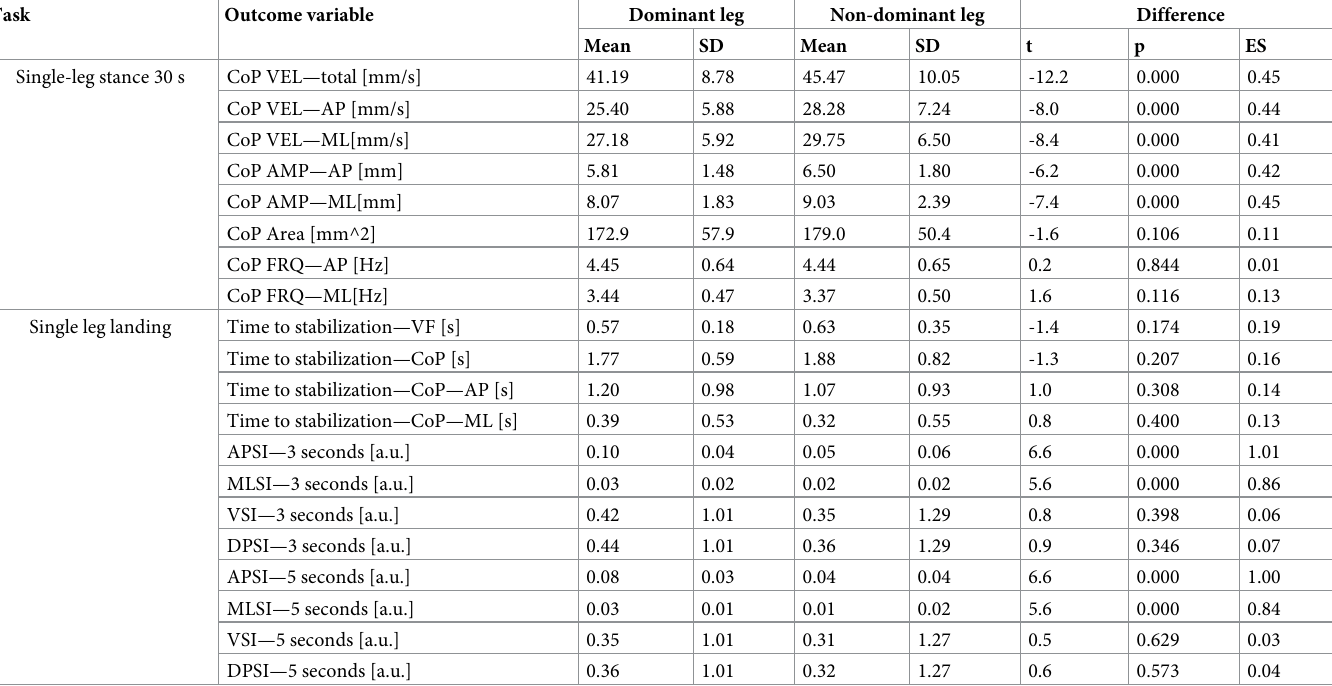
Table 3. Effect of leg dominance (based on total center of pressure velocity during quiet stance) on body sway and landing variables. Task Outcome variable Single-leg stance 30 s